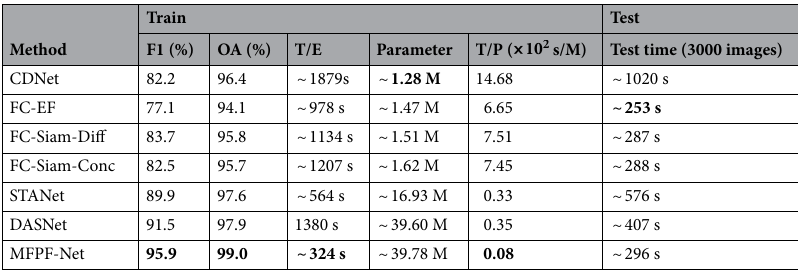
Table 9. Performance and speed trade-offs (the best performance is emphasized in